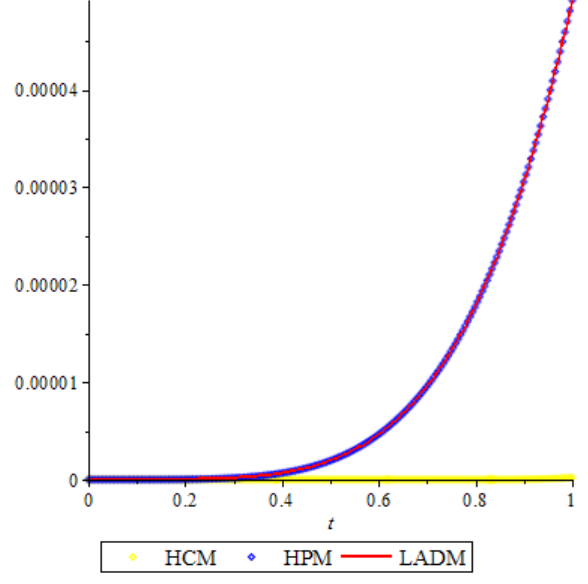
Figure 1. Comparison of the error function E 1,5 ( t ) for S ( t ).